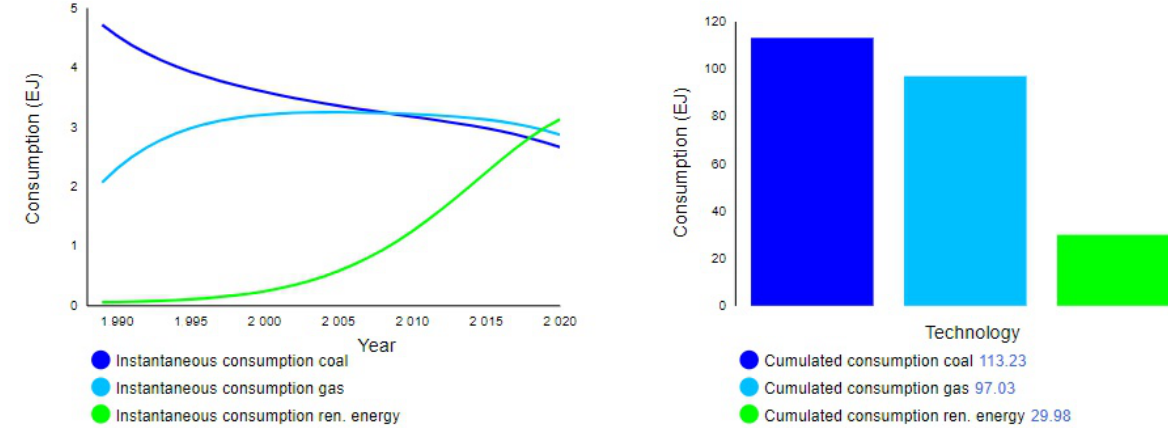
Figure 5. Simulation of coal, natural gas, and renewable energy consumption in the observed